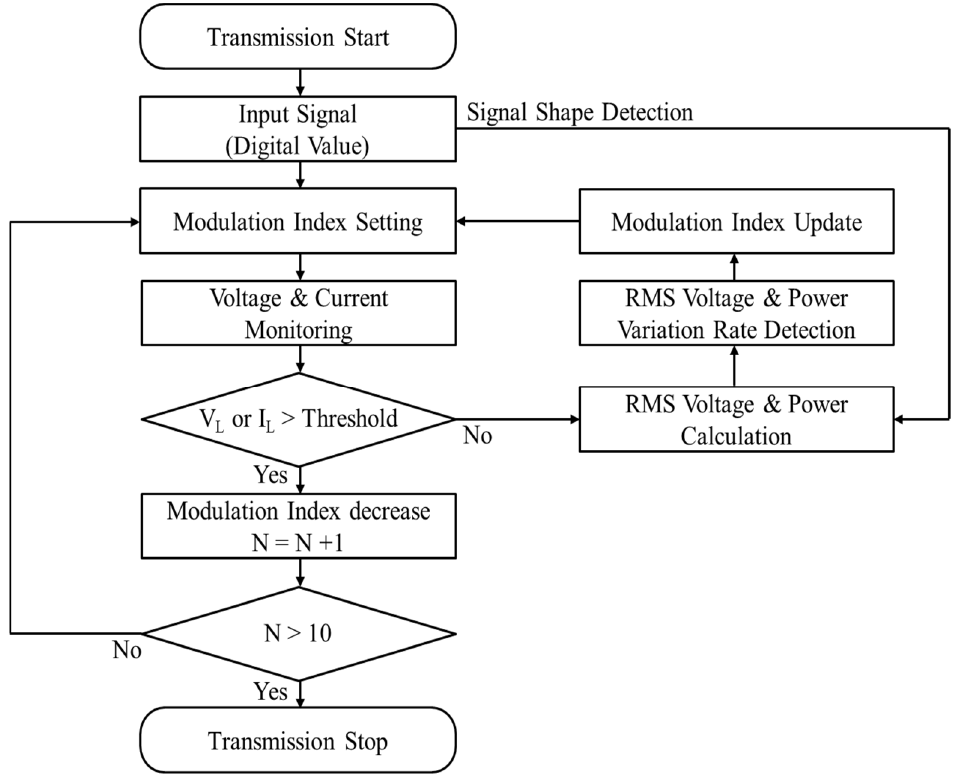
Figure 7. The control algorithm flowchart of the transmitter.